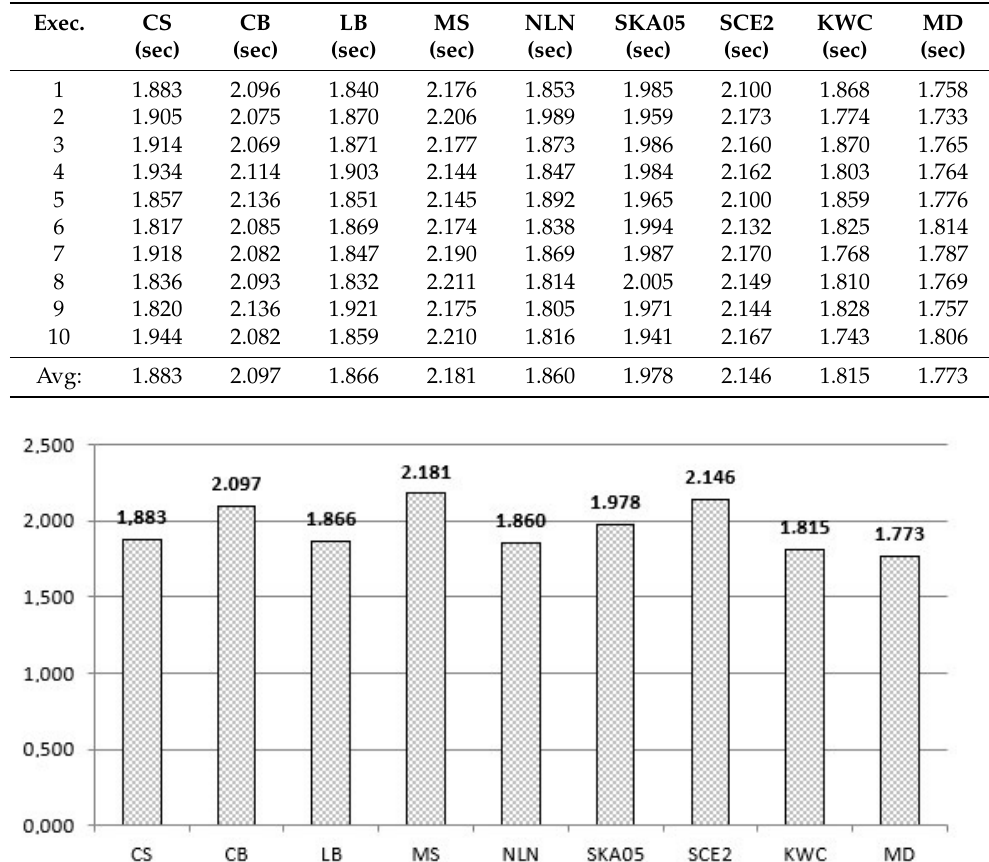
Figure 26. Average time of each algorithm for clipping 10 million lines (lower value –>